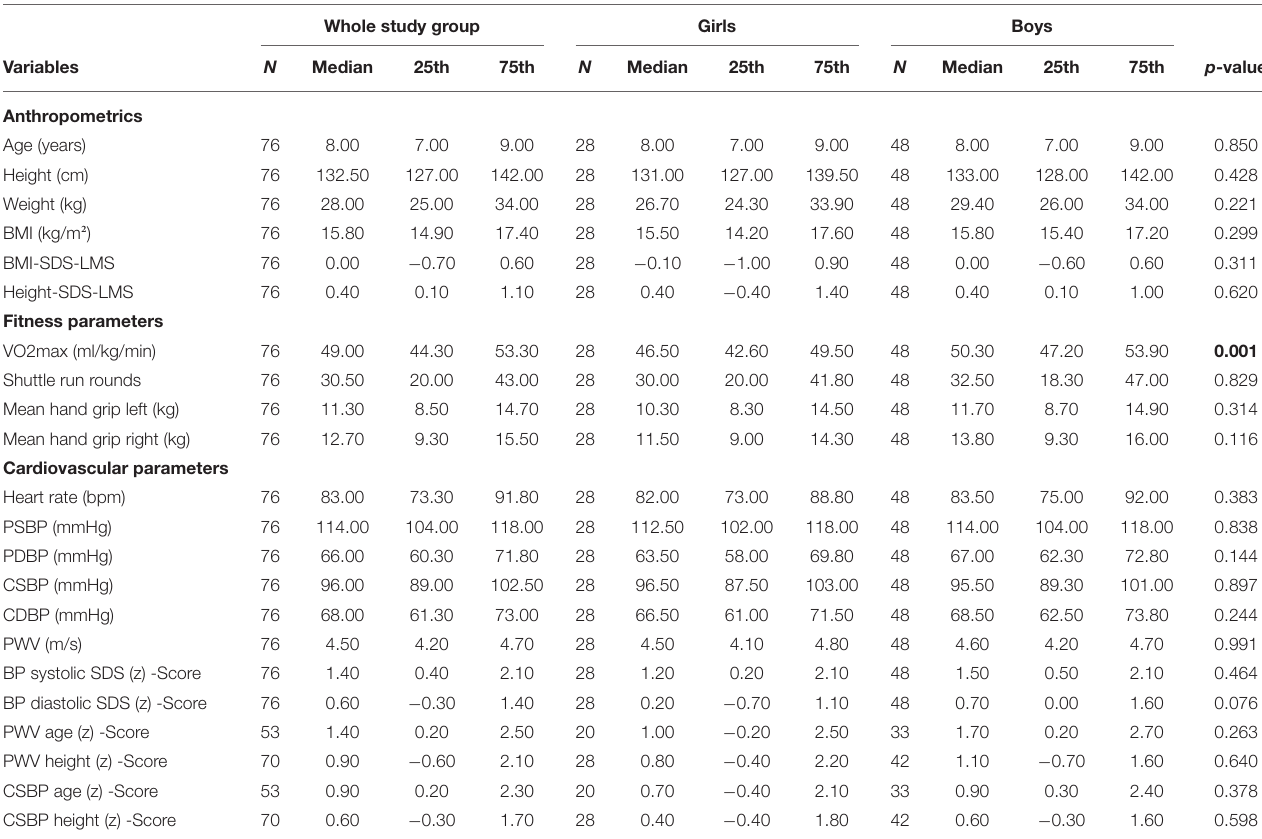
Table 3 depict weight and blood pressure categories and mean values / standard deviations divided by sex and in + −